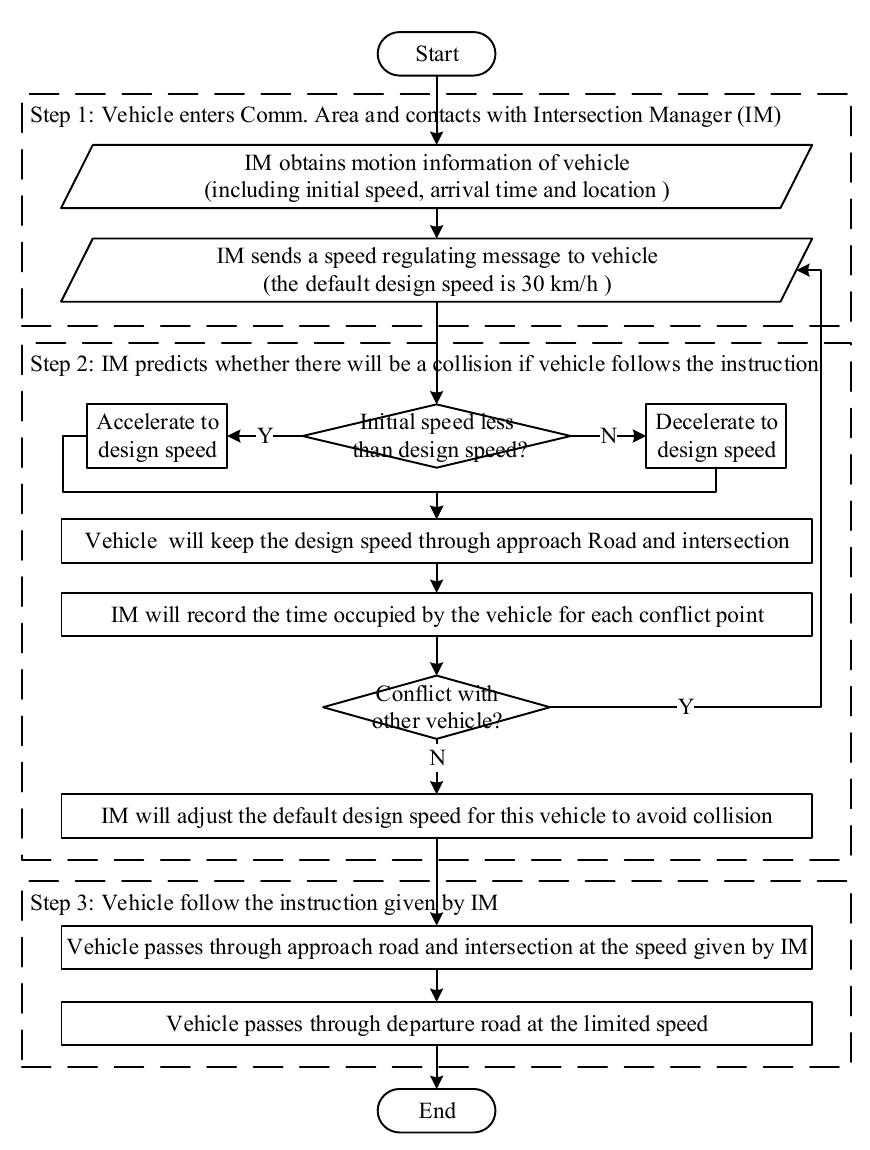
Figure 9. Flowchart of conflict detection and resolution.